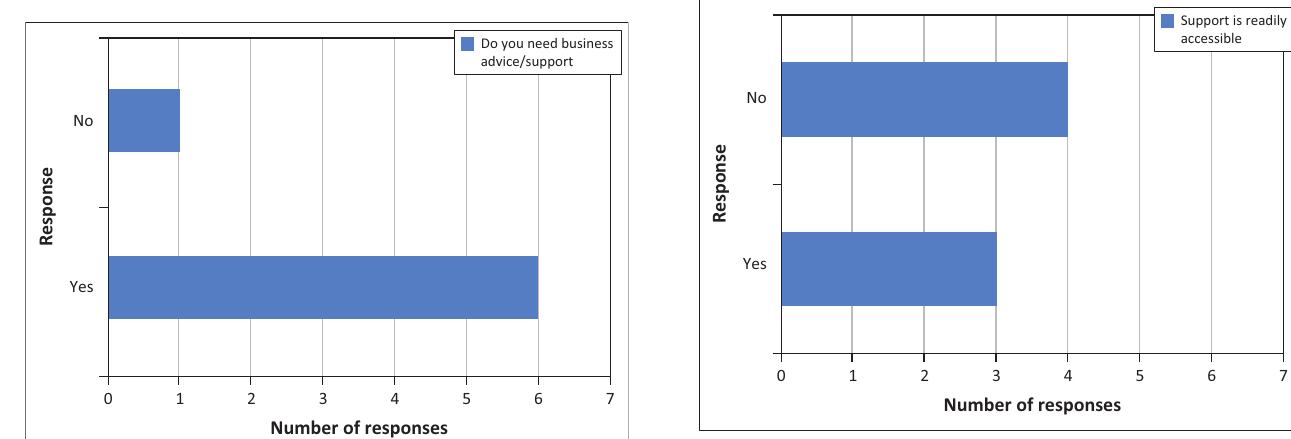
FIGURE 8: Availability of support.